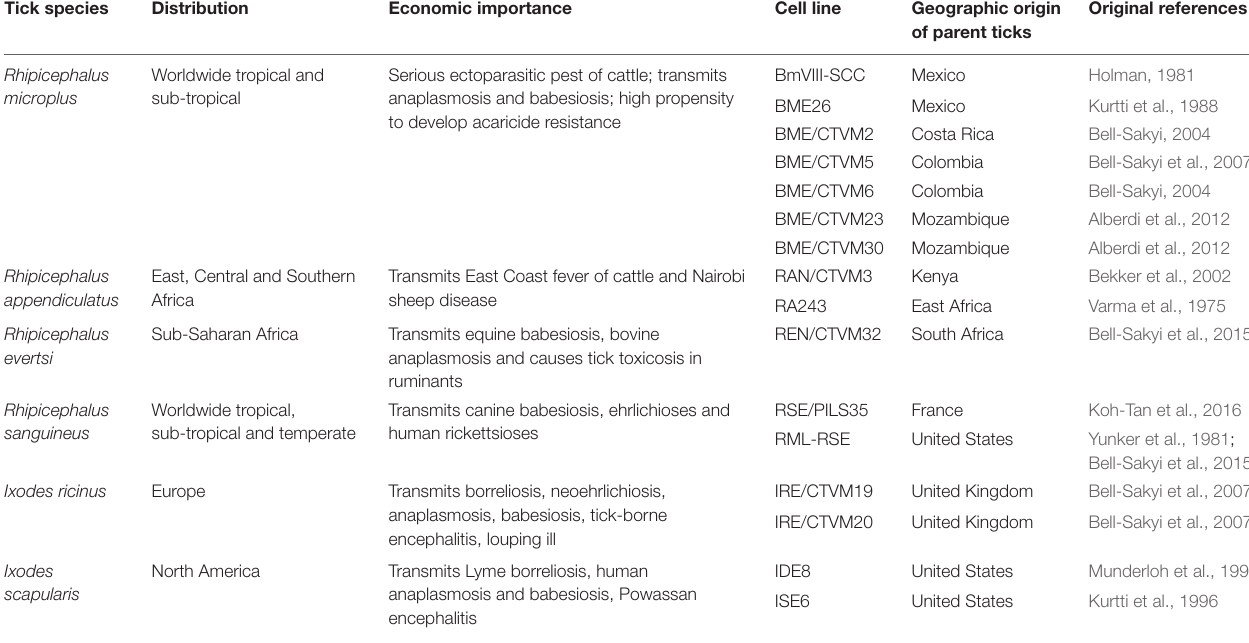
TABLE 1 | Tick cell lines used in studies on tick control reviewed in this article.